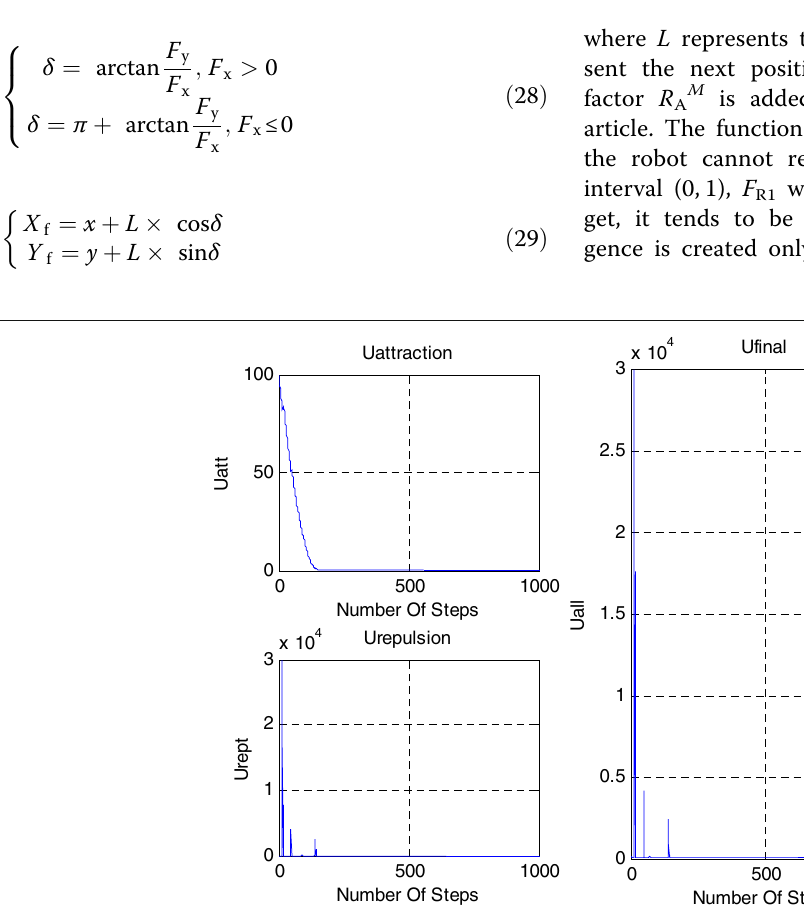
Fig. 12 The energy amount of repulsion and attraction and their yields according to the number of steps in the modified artificial potential field algorithm for circular obstacles with radius R =